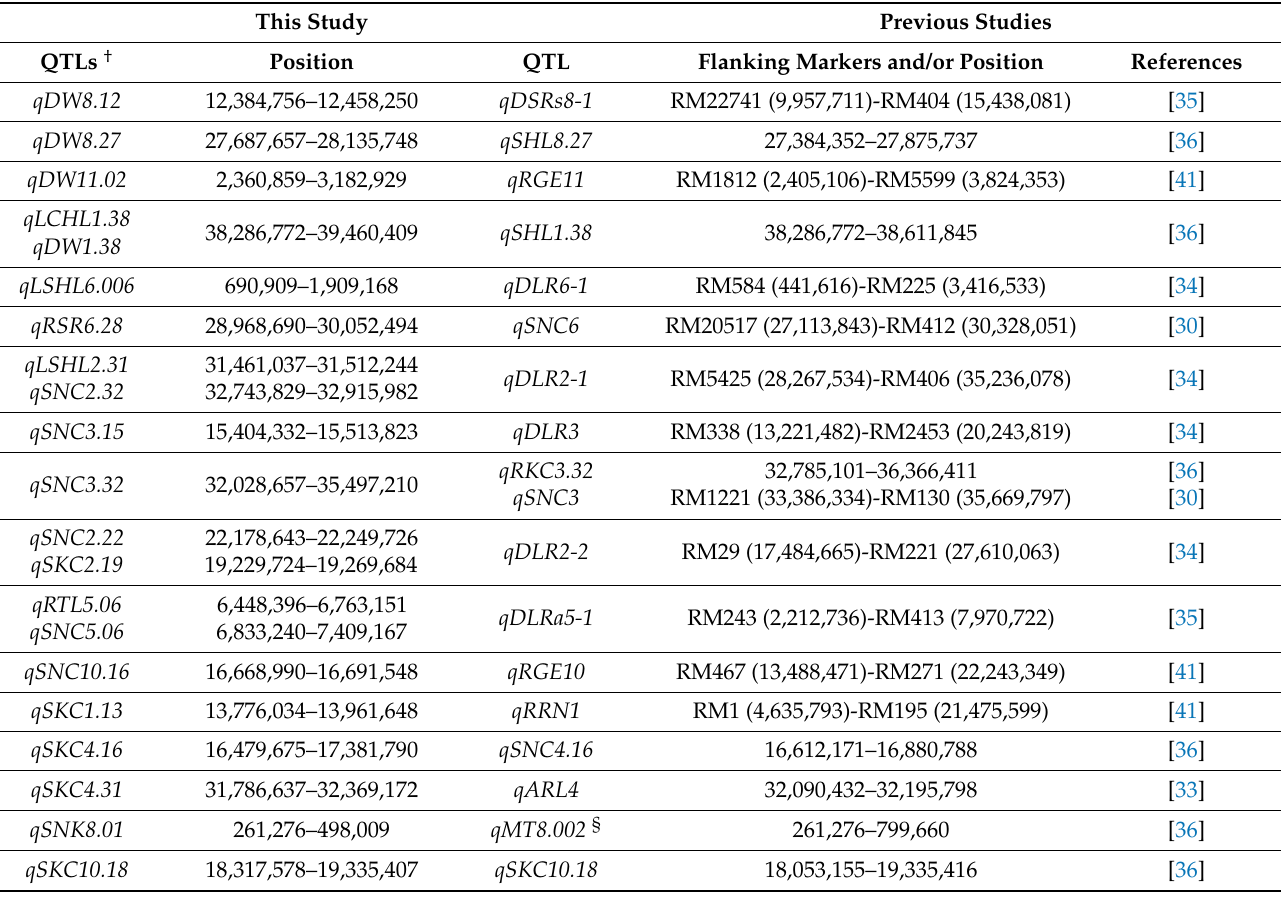
Table 5. Summary of additive QTLs co-localized with QTLs detected in previous alkalinity